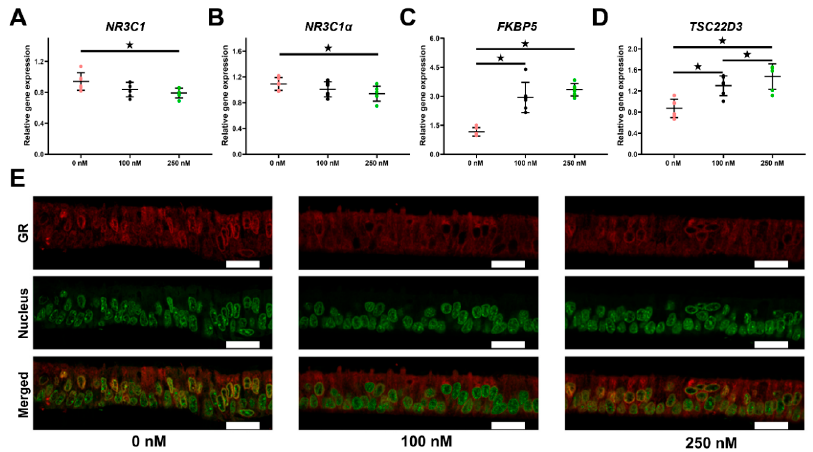
Figure 2. Activation of the glucocorticoid receptor (GR)-signaling pathway by cortisol in ALI-POEC. Differential marker gene expression of ( A ) NR3C1 , ( B ) NR3C1 α , ( C ) FKBP5 , and ( D ) TSC22D3 . Data are shown as mean with SD. Asterisks indicate a significant difference at p < 0.05. n = six animals. ( E ) Immunofluorescence staining of GR (red fluorescence) in ALI-POEC, nuclei stained with SYBR Green I; scale bar = 20 µm.